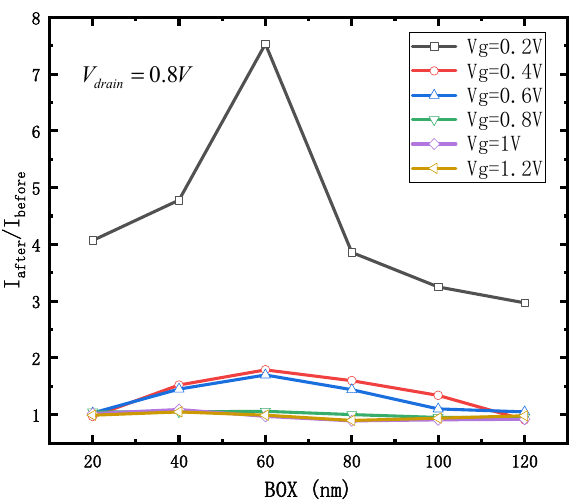
Figure 10. I after /I before with different thicknesses of BOX layer.